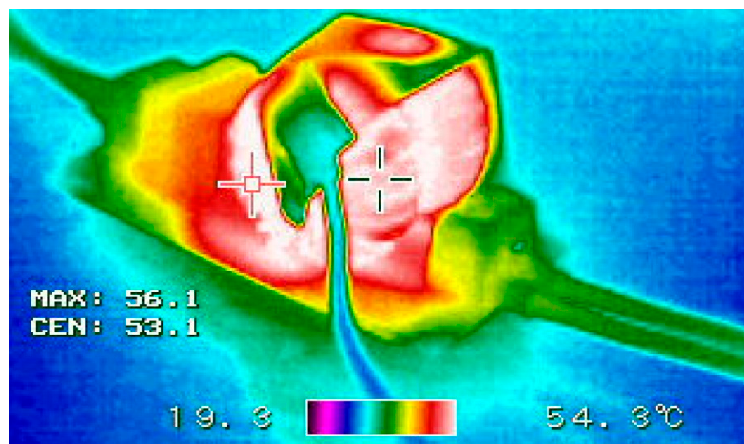
Figure 10. Thermographic photograph of the filter.